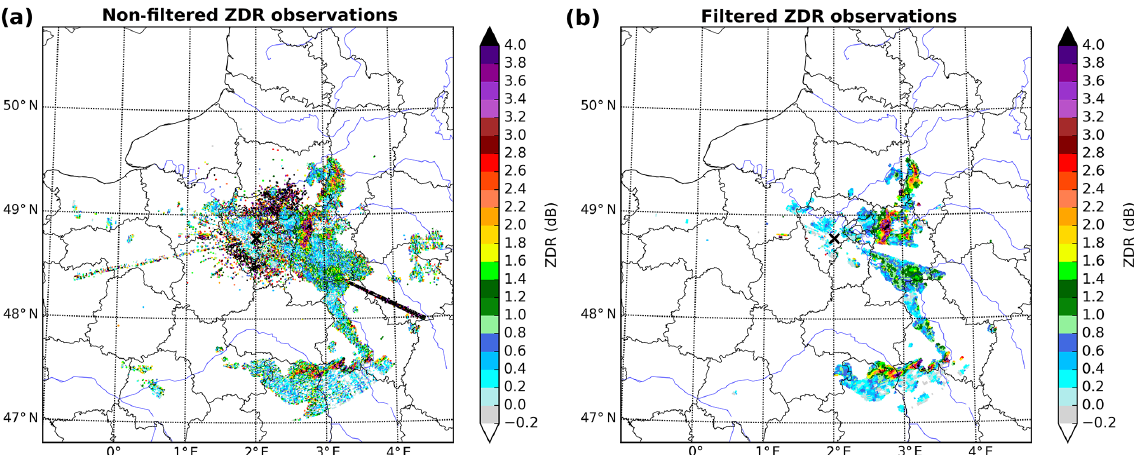
Figure 4. Filtering effects on Z DR observed by the Trappes radar during a convective event on June 2018 06:00UTC, for an elevation of 0.4 ◦